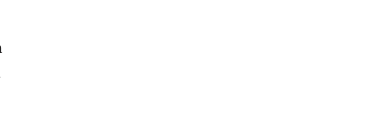
TABLE 1 Does levothyroxine replacement improve cardiovascular outcomes in patients with CHF? PICO